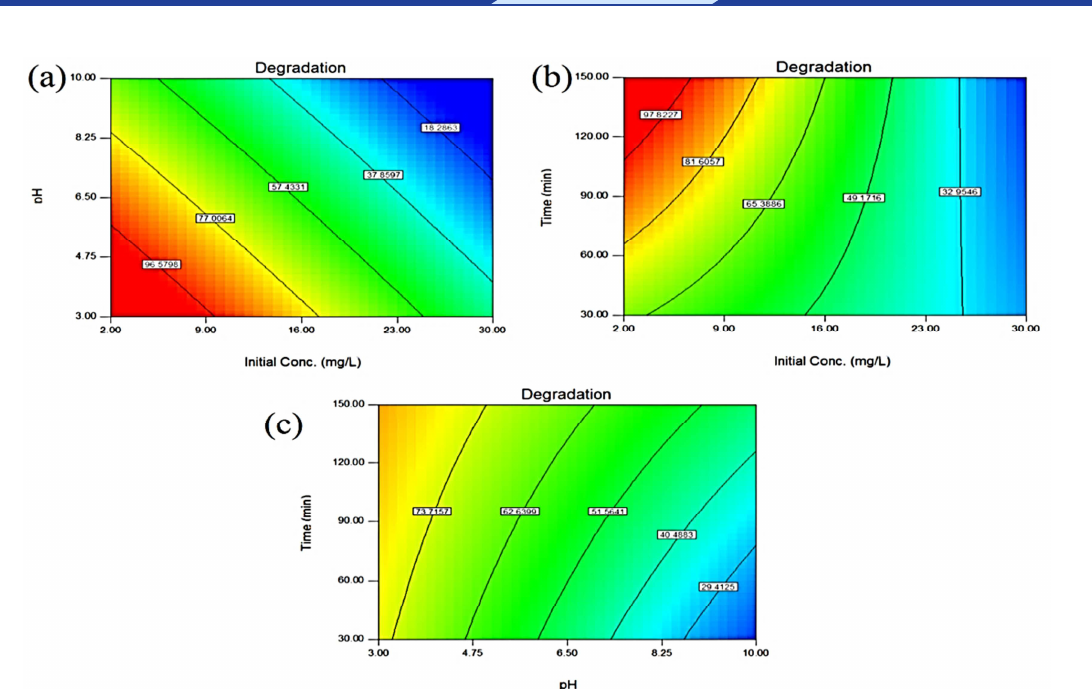
Figure 3. Two-dimensional plots for photocatalytic humic substances degradation Figure 2 represents the predicted versus actual efficiency